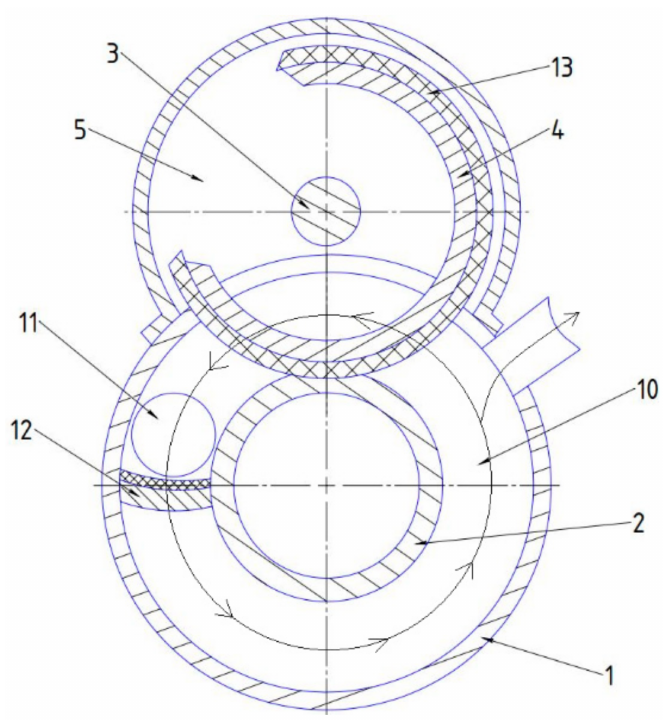
Figure 16. Sketch of the body cylindrical segment.